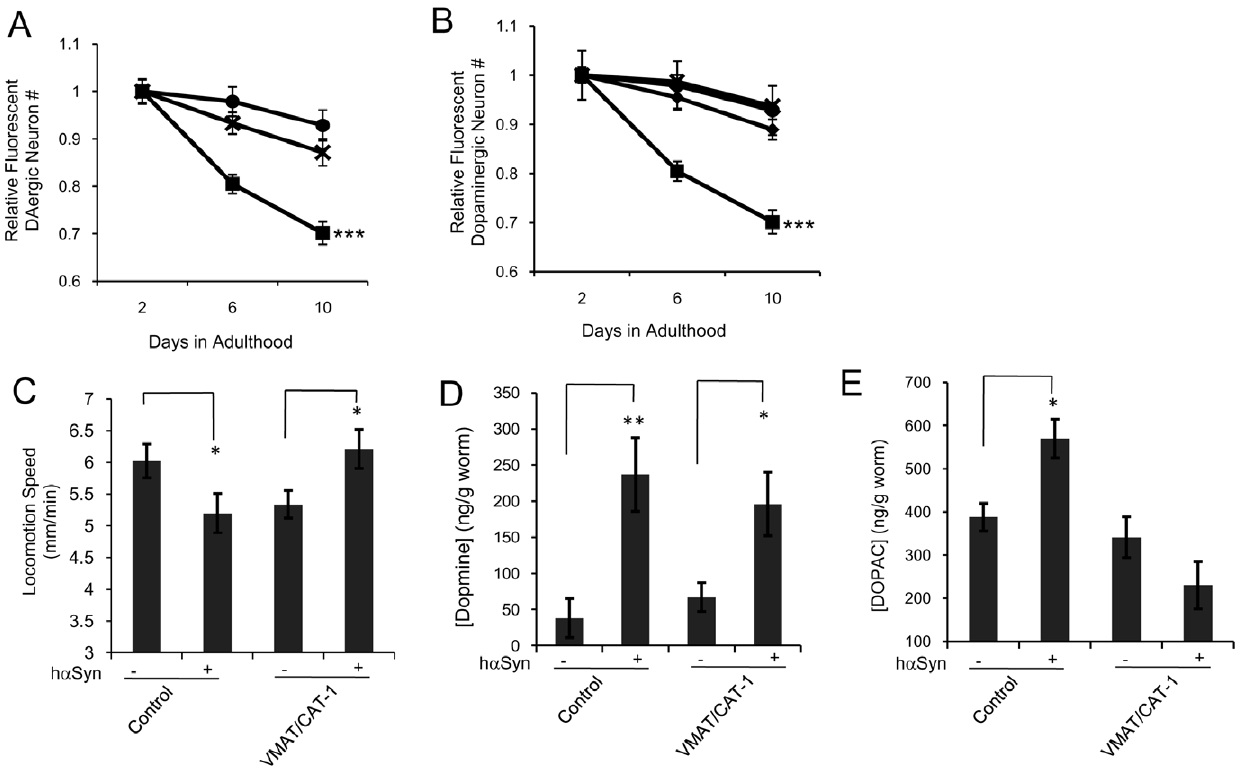
Figure 6. Overexpression of VMAT protects DAergic neurons from h a Syn toxicity. A, Quantification of fluorescent DAergic neurons of wild type (circles), VMAT/CAT-1 KO (crosses), and h a Syn expressing wild type (squares) worms. Error bars represent the SEM of three independent experiments. In each experiment, n of each sample varied from 10 to 25. ***, p , 0.005 (Two-way ANOVA). B, Quantification of fluorescent DAergic neurons in wild type (circles), h a Syn expressing wild type(squares), VMAT/CAT-1 overexpressing (diamonds), and h a Syn expressing VMAT/CAT-1 overexpressing (crosses) worms. Error bars represent the SEM of three independent experiments. In each experiment, n of each sample varied from 10 to 30. ***, p , 0.005 (Two-way ANOVA). C, Locomotion speed of day 2 adult worms of control and VMAT/CAT-1 overexpressing lines with or without h a Syn expression. *: p , 0.01 (t-test). n $ 10. Error bars:SEM. D. Quantification of [dopamine] in day 2 adult worms of control and VMAT/CAT-1 overexpressing lines with or without h a Syn expression. Error bars represent the SEM of three independent experiments. In each experiment, the number of worms per sample was about 200. *: p , 0.01 (t-test), **: p , 0.005 (t-test). E. Quantification of [DOPAC] in day 2 adult worms of control and VMAT/CAT-1 overexpressing lines with or without h a Syn expression. Error bars represent the SEM of three independent experiments. In each experiment, the number of worms per sample was about 200. *: p , 0.01 (t-test). DsRed; Right, Merged image of CAT-2::GFP and DsRed. (C) Quantification of DAergic neuron degeneration by using CAT- 2::GFP (green) or DsRed (red) in h a Syn-expressing (diamonds) and control (circles) lines. Data represent mean 6 S.E.M., n= 30. Error bars may hide in symbols. ***, p , 0.005 (Two-way ANOVA to compare h a Syn expressing and control line) (green: CAT- 2::GFP; Red DsRed). 1 represents 7.9 and 7.7 in DsRed and CAT-2/TH::GFP experiments, respectively. Found at: doi:10.1371/journal.pone.0009312.s003 (1.44 MB TIF) Figure S4 h a Syn expression does not affect serotonin neuro- transmission. Enhanced slowing responses of day 2 adult worms. GFP indicates a wild type worm line expressing GFP in DAergic neurons. Food response experiments were conducted with (grey bars) or without (black bars) food. Found at: doi:10.1371/journal.pone.0009312.s004 (0.23 MB TIF) Figure S5 h a Syn expression disrupts dopamine synaptic vesicle distribution in TH/CAT-2 knockout background. A–D, Typical bright field (A) or confocal laser scanning VMAT/CAT-1::GFP (B–D) images of living L2 worms expressing both VMAT/CAT- 1::GFP and h a Syn in a TH/CAT-2 knockout background. C and D are magnified areas of B that show DAergic and serotonergic